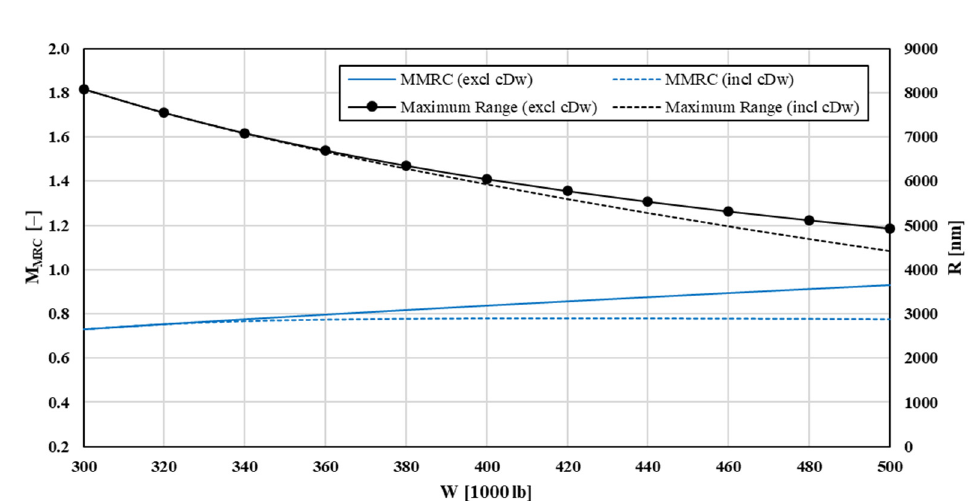
Figure 7. M MRC and range for variable in-flight weight for both drag models, with and without transonic wave drag.